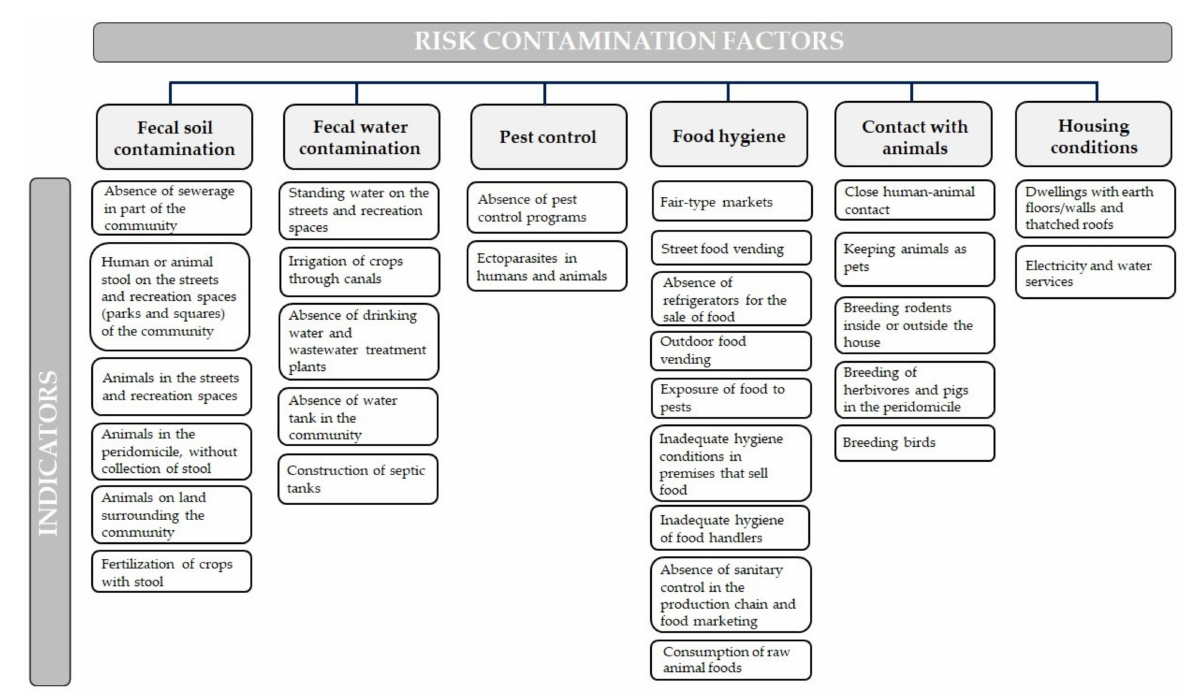
Figure 7. Risk contamination factors of infection in communities of San Andr é